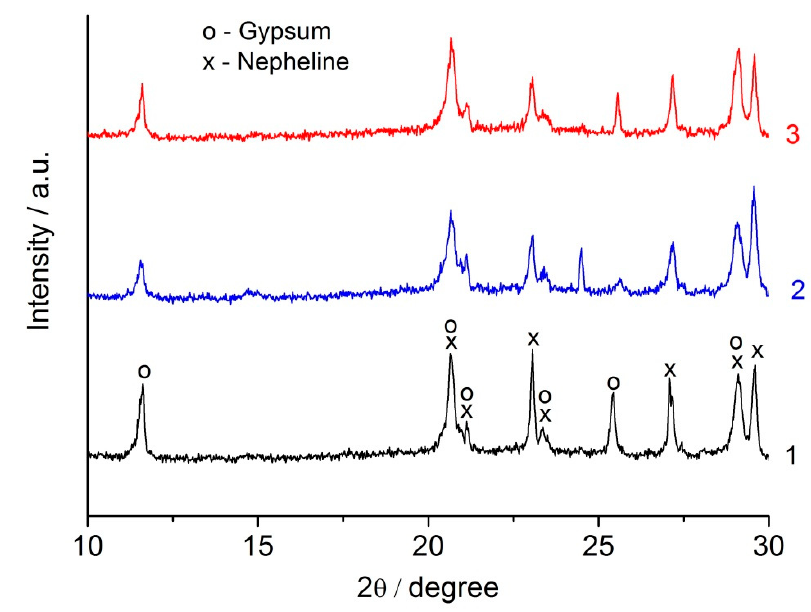
Figure 8. X-ray diffraction patterns: the initial (50% NC + 50% gypsum) mixture (1); the mechanically activated for 270 s (50% NC + 50% gypsum) mixture (2); 1 day-old paste prepared using the mechanically activated for 270 s (50% NC + 50% gypsum) mixture cured at relative humidity of 60–70% (3). The main crystalline peaks are labeled.